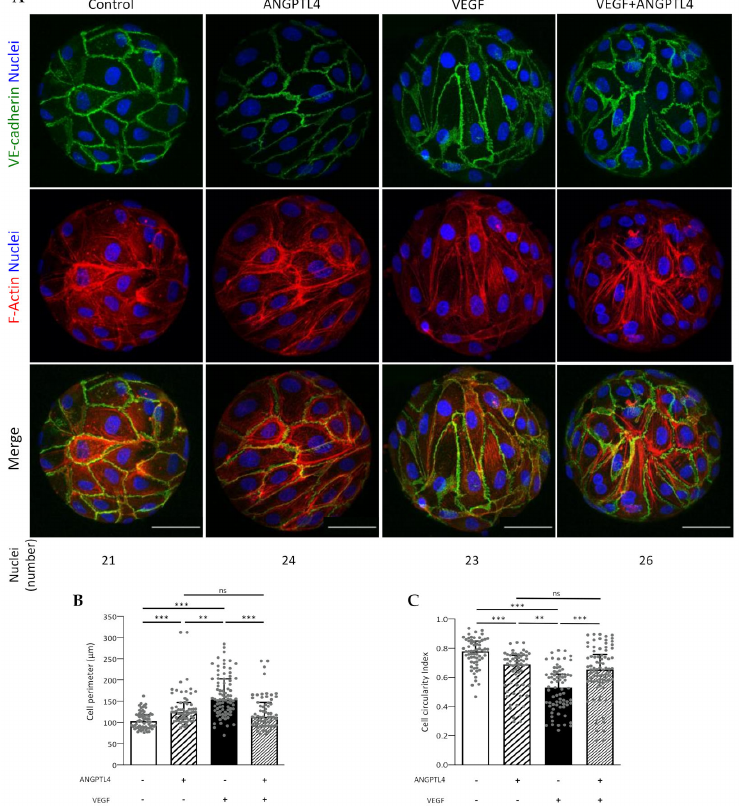
Figure 3. Regulation of migratory-related endothelial behavior by ANGPTL4 and VEGF in the early step of angiogenesis. ( A ) Endothelial cells seeded on beads and incubated without or with ANGPTL4 (2.5 µ g/mL) and/or VEGF (50 ng/mL) for 5 h. Cells were fixed and labelled for VE-cadherin (green), F-actin (red), and nuclei (blue). The number of visible nuclei per bead is indicated below the panels. Scale bar: 50 µ m. ( B ) Median values of cell perimeter (+interquartile). ( C ) Median values of cell circularity index (+interquartile). Values were measured on 62 to 83 cells per conditions in at least three independent experiments. ns: p > 0.05, ** p ≤ 0.01, *** p ≤ 0.001